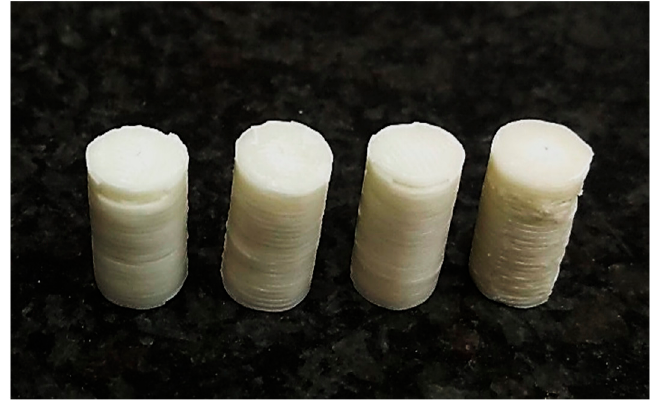
Figure 5. Representative dense samples, showing well-constructed cylinders with regular dimensions.